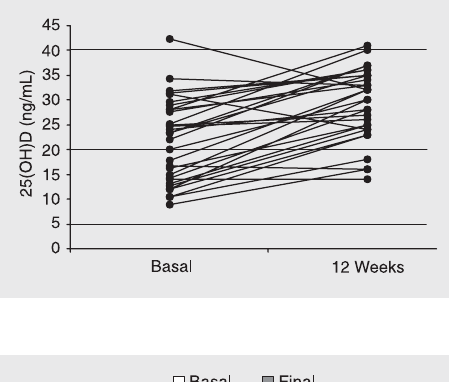
Figure 2. Variation of 25(OH)D levels among the groups of pa- tients that received cholecalcif- erol for 12 weeks according to their initial levels of plasma 25(OH)D: lower than 20 ng/ml (N = 15, left) and higher than 20 ng/mL (N = 16, right). Basal val- ues are given in the open col- umns and final values are given in the filled columns. 25(OH)D = 25-hydroxyvitamin D. *P < 0.05 for the comparisons shown (Stu- dent t